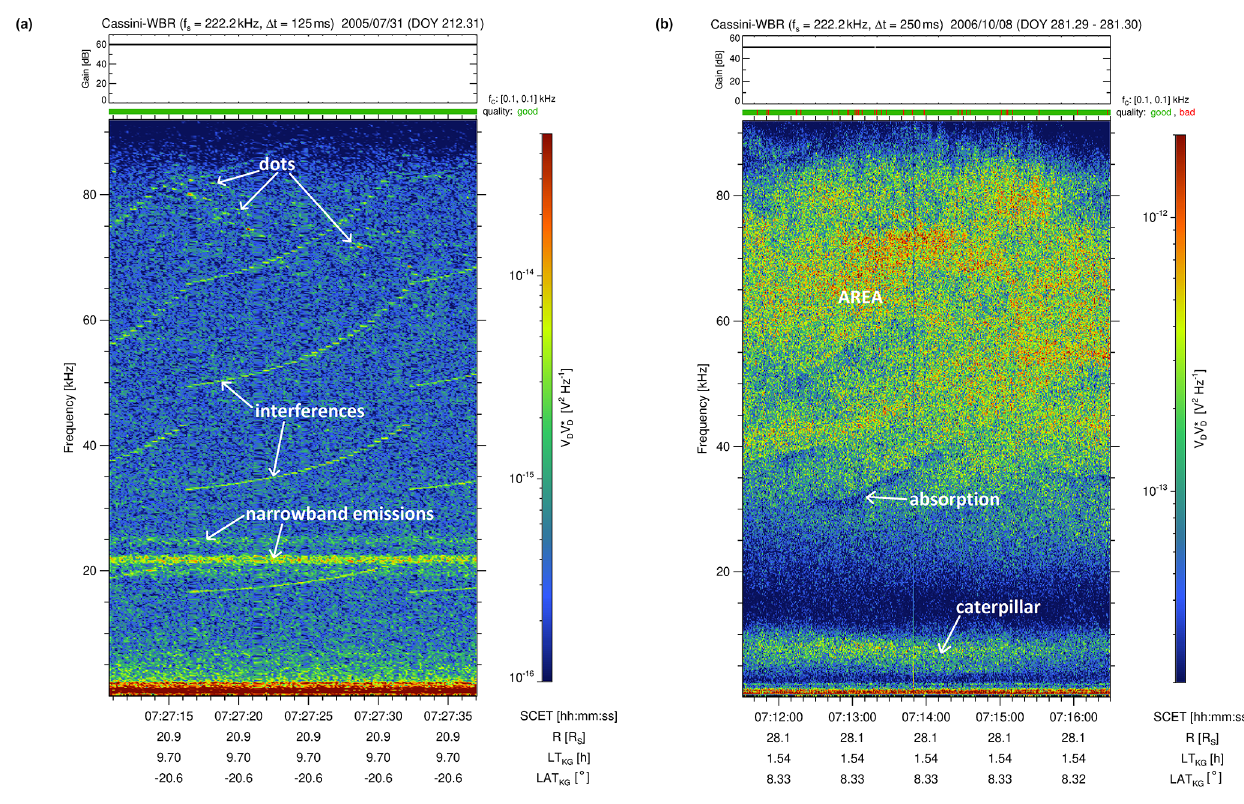
Figure 1. Fine structures of the classes DOTS (a) and AREA (b) reveal dot-like and patchy features of Saturn kilometric radiation, re- spectively. These Cassini WBR spectra show the color-coded auto-power spectral density of the radio waves received by the electric dipole antenna as a function of time ( x axis in hh:mm:ss) and frequency ( y axis in kHz). The numbers at the bottom denote the spacecraft event time (SCET), the distance of Cassini to Saturn’s center in Saturn radii R S , the local time (LT) of the spacecraft in hours, and its latitude (LAT) in kronographic (KG) coordinates in degrees. At the top, one can find the sampling frequency f S , the time resolution (cid:49)t , the date of the measurement, and additionally the day of year (DOY) is given in brackets. Furthermore, there is a panel indicating the gain state of the WBR in steps of 10dB and a green (or partly red) bar indicating the quality of the data. The color bar on the right gives the auto-power spectral density in V 2 Hz − 1